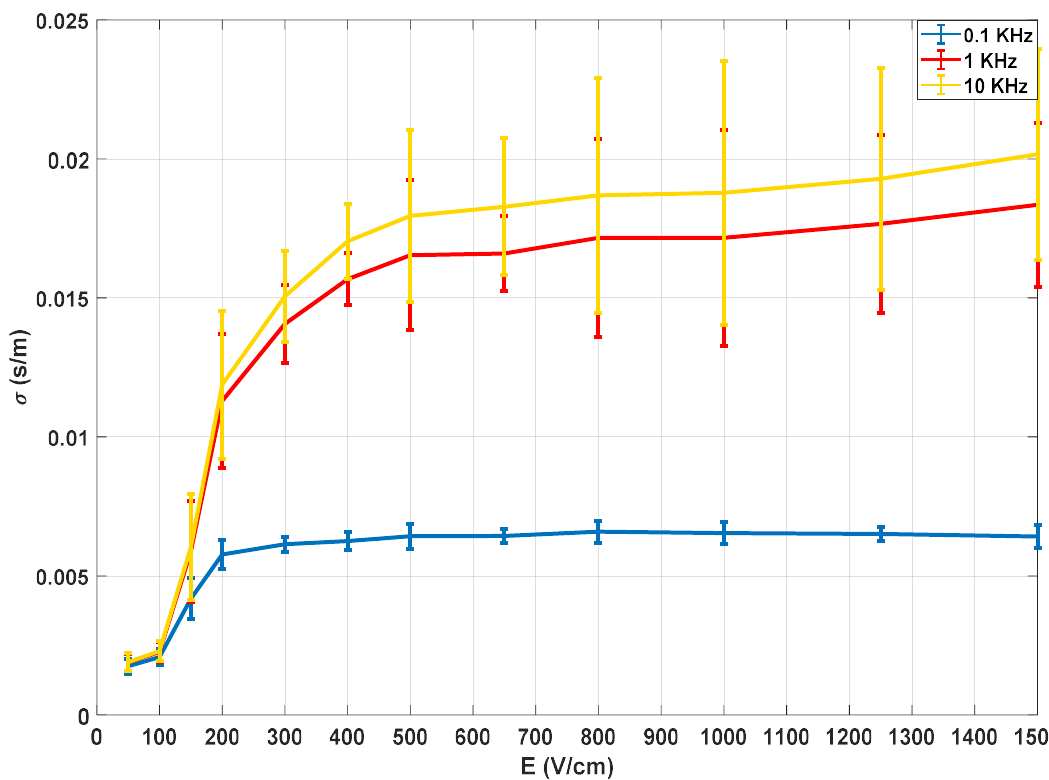
Figure 8. Electrical conductivity of distilled water and potato sample 1.5 h after the electroporation process.